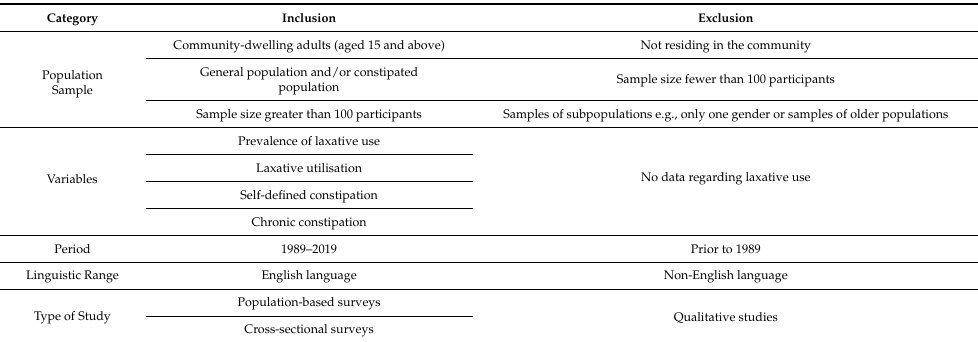
Table 1. Literature inclusion and exclusion